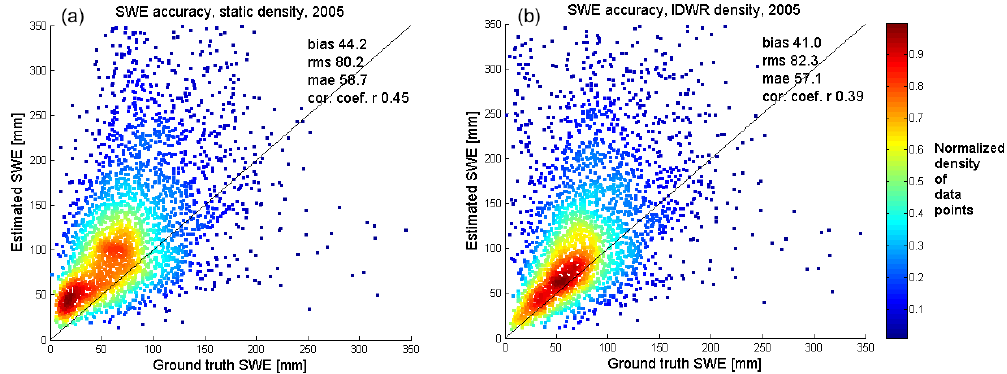
Figure 7. Scatter plots showing the normalized density of scattered points and validation parameters for SWE retrievals without final assim- ilation with static density (a) and IDWR-interpolated dynamic density (b) for